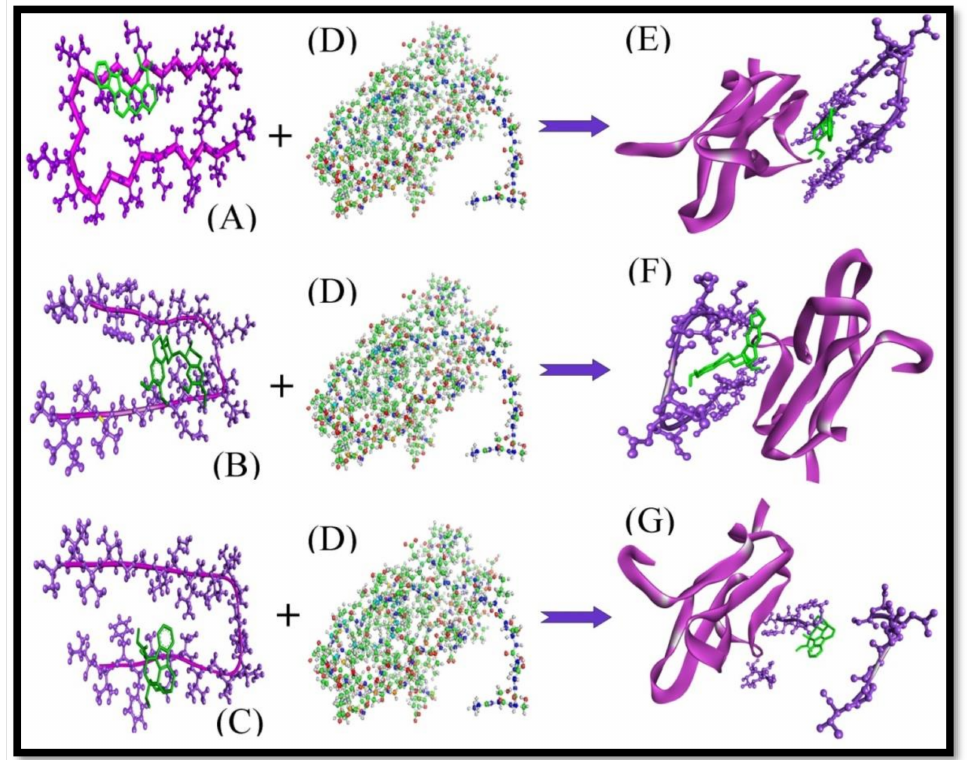
Figure 3. The complex-protein interaction. ( A ) The complex of A β + Ajm, ( B ) the complex of A β + Eme, ( C ) the complex of A β + Vnc. ( D ) Structure of RAGE protein. (E) The interacting complex structure of (A β + Ajm) with RAGE obtained by the protein-protein docking method. ( F ) The interacting complex structure of (A β + Eme) with RAGE obtained by the protein-protein docking method. ( G ) The interacting complex structure of (A β + Vnc) with RAGE obtained by the protein-protein docking